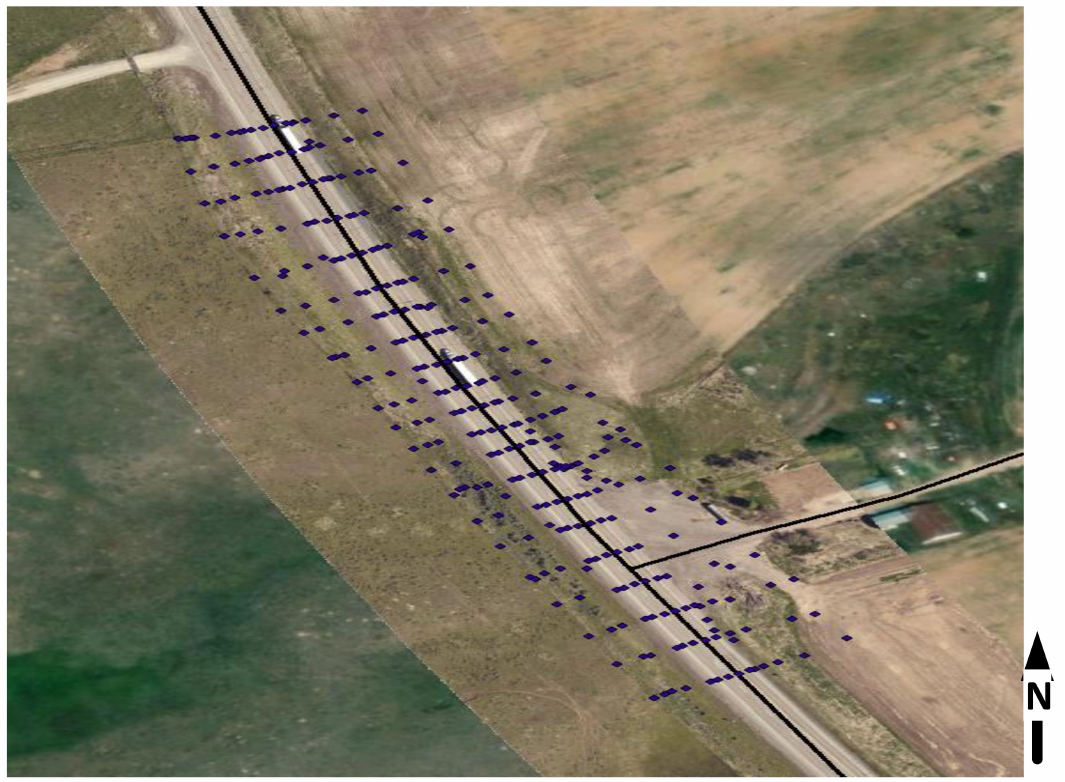
Figure 3. Survey points imported in ArcMap—Study Segment